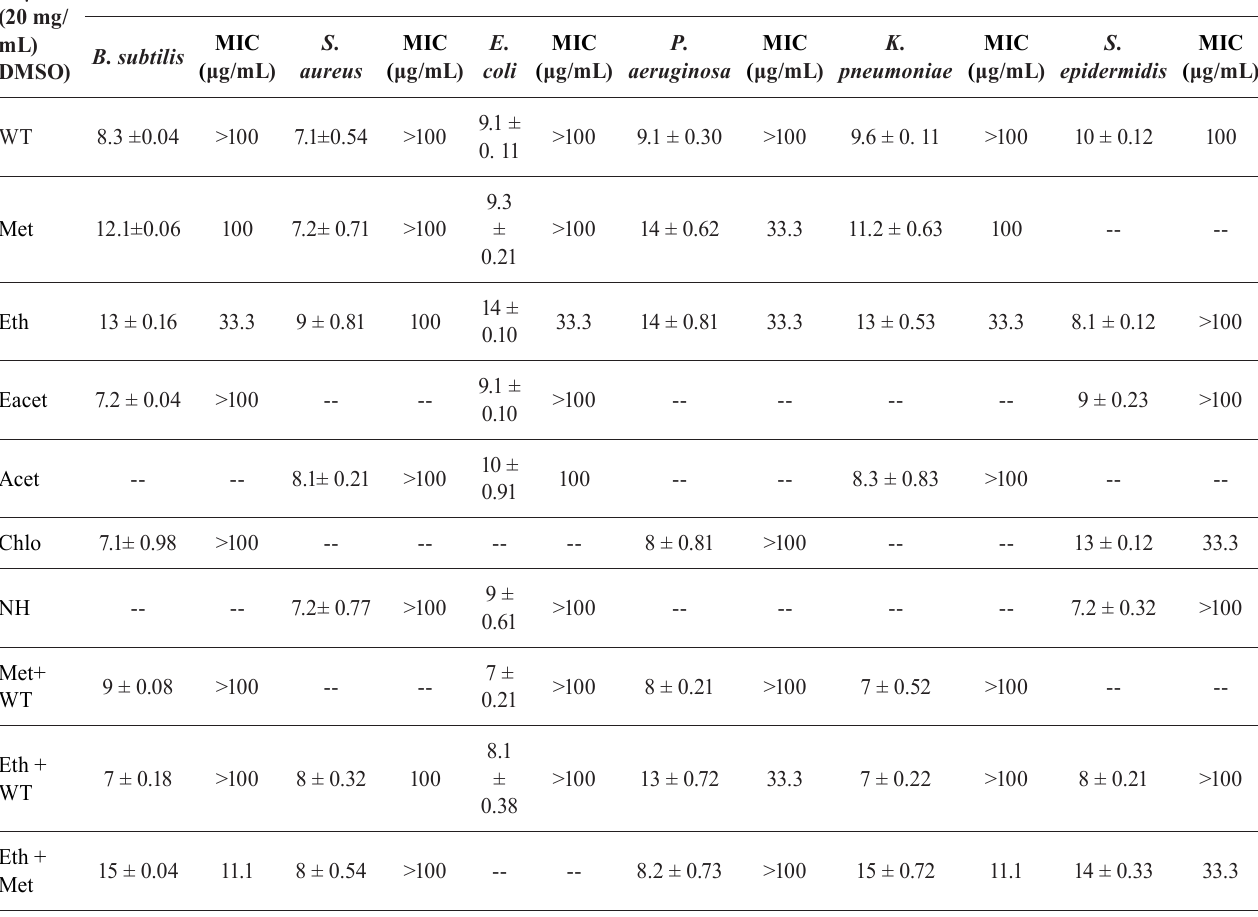
TABLE II - Antibacterial activities of different solvent extract of E. intermedia Sample Zone of growth inhibition (mm ± SD) and MIC